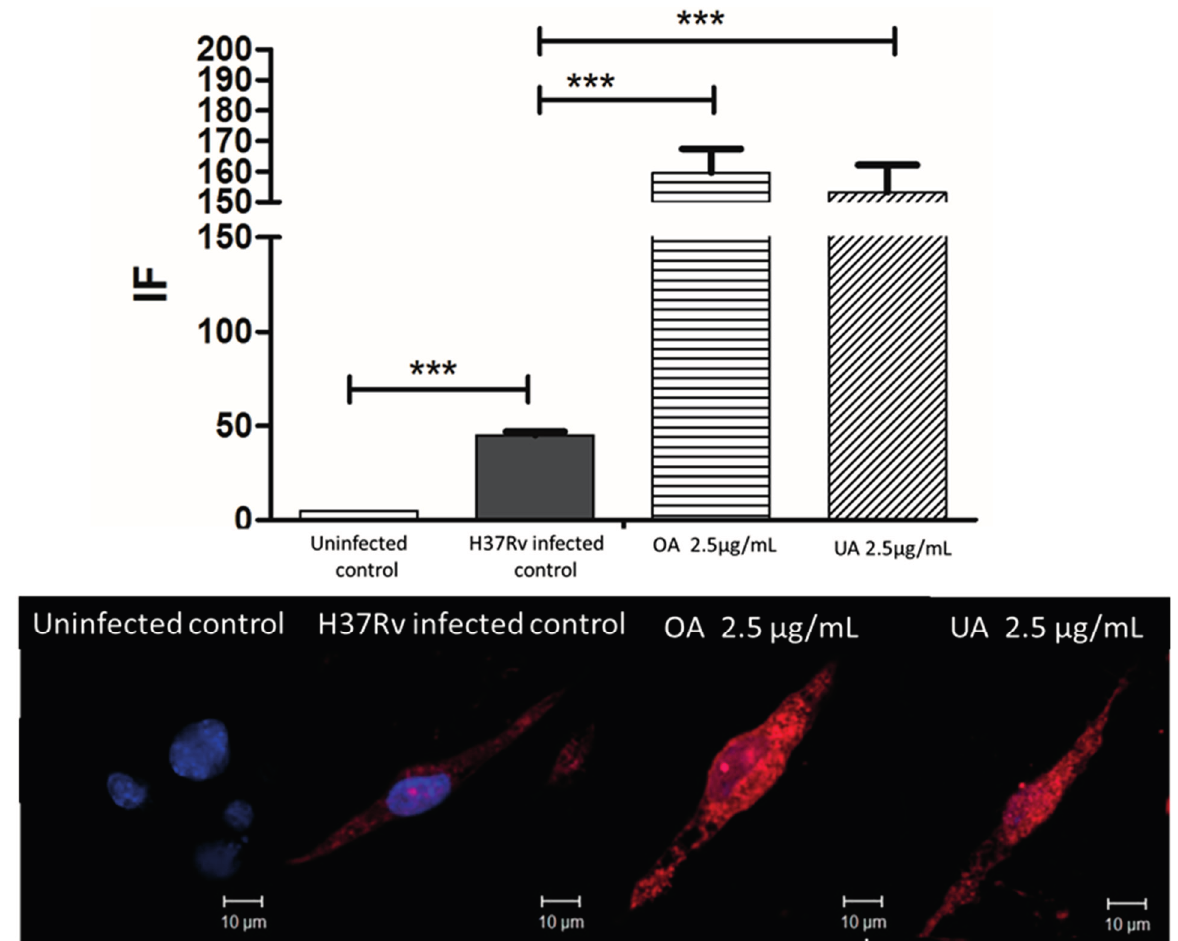
Figure 8. TGR5 expression in macrophages infected with MTB H37Rv and treated with OA and UA. Macrophages were infected for 2 h and then treated with UA and OA 2.5 µg/mL each for 24 h. At this time cells were stained by indirect immunofluorescence with anti-TGR5 antibody labeled with rhodamine. Upper panel) Mean fluorescence intensity was recorded with LSM Pascal V 5.1 software. Lower panel) Confocal images of control macrophages (Uninfected control); of macrophages infected with MTB H37Rv (H37Rv infected control); and macrophages infected with MTB H37Rv and treated with OA (OA 2.5 µg/mL) and UA (UA 2.5 µg/mL), respectively. The red label depicts TGR5 receptor. The blue label corresponds to cell nuclei stained with DAPI. Statistically significant differences are indicated (*** p < 0.001), when infected/treated cells values (OA, UA) were compared with infected cells (H37Rv), or when non-infected cells (J774 A.1) were compared with infected cells